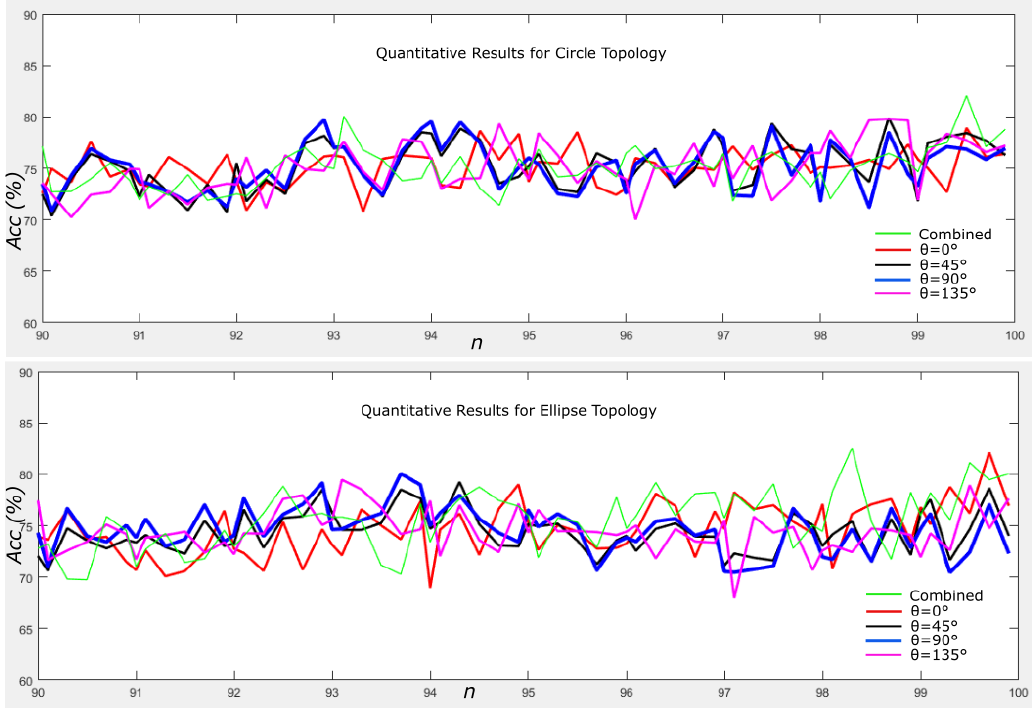
Figure 17. Quantitative results using different orientations evaluated on the InBreast dataset [15]. Note that the x- axis and y- axis represent the accuracy (percentage of correctly classified cases) and the percentage of dominant patterns,